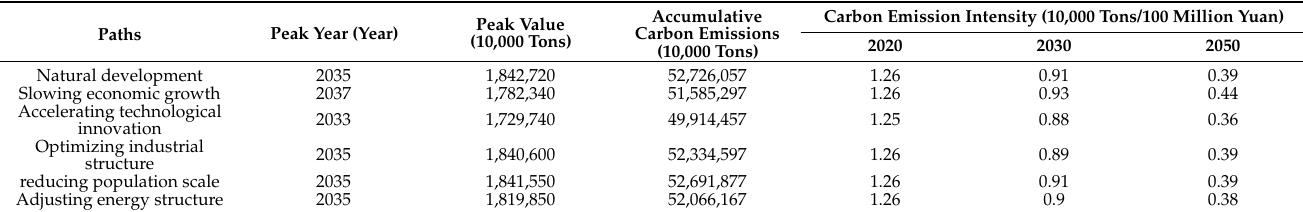
Figure 5. China’s carbon emission forecast for different paths from 2020 to 2050 (Unit: 10,000 tons). Table 3. China’s carbon emission forecast for different paths from 2020 to 2050.